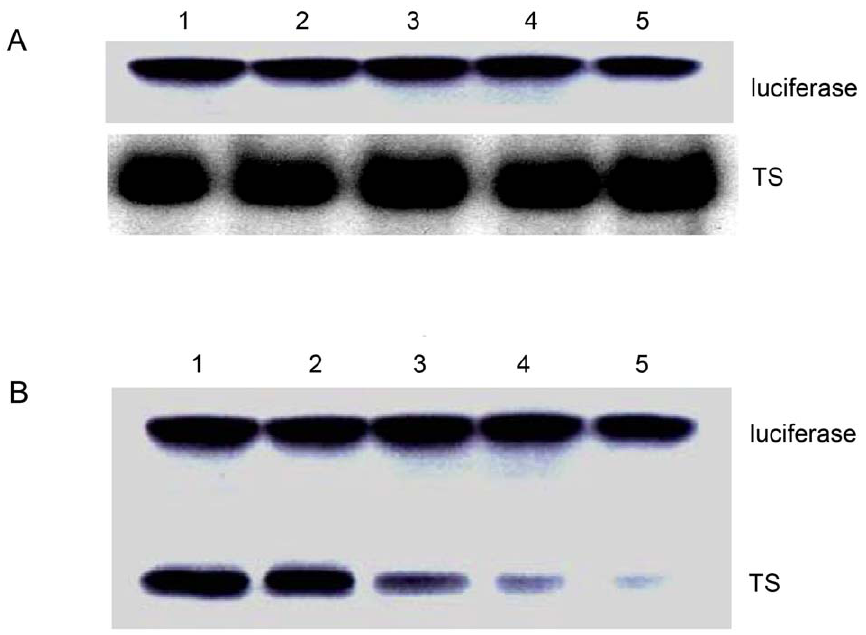
Figure 7. TS protein inhibited in vitro translation of zebrafish TS mRNA. A rabbit reticulocyte lysate in vitro translation system was used to determine the interaction between mRNA and TS protein. Incubation of zebrafish TS mRNA with the reticulocyte lysate yielded a protein product with a molecular mass of approximately 35 kDa. A , Zebrafish TS mRNA was incubated in the rabbit reticulocyte lysate system without (lane 1) or with 100 ng of BSA (lane 2), luciferase (lane 3), human p53 protein (lane 4) or alpha-chymotrypsin (lane 5). B , Excess TS protein was included in the reaction mixture. Zebrafish TS mRNA was incubated in the translation system without (lane 1) or with 1 ng (lane 2), 10 ng (lane 3), 100 ng (lane 4) or 200 ng (lane 5) TS